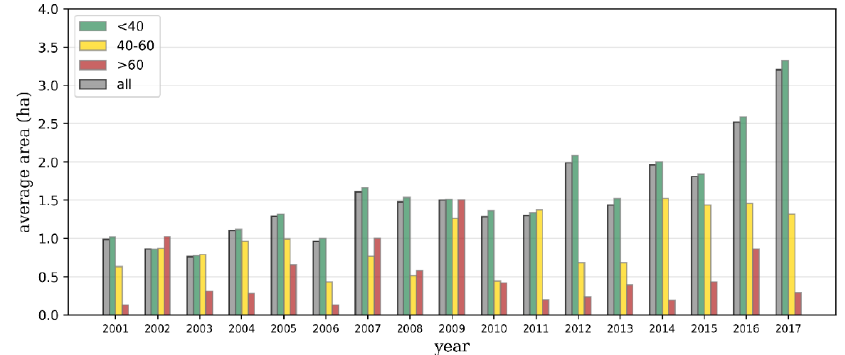
Figure 13. Evolution of the average harvested site area over time (by slope class, %).